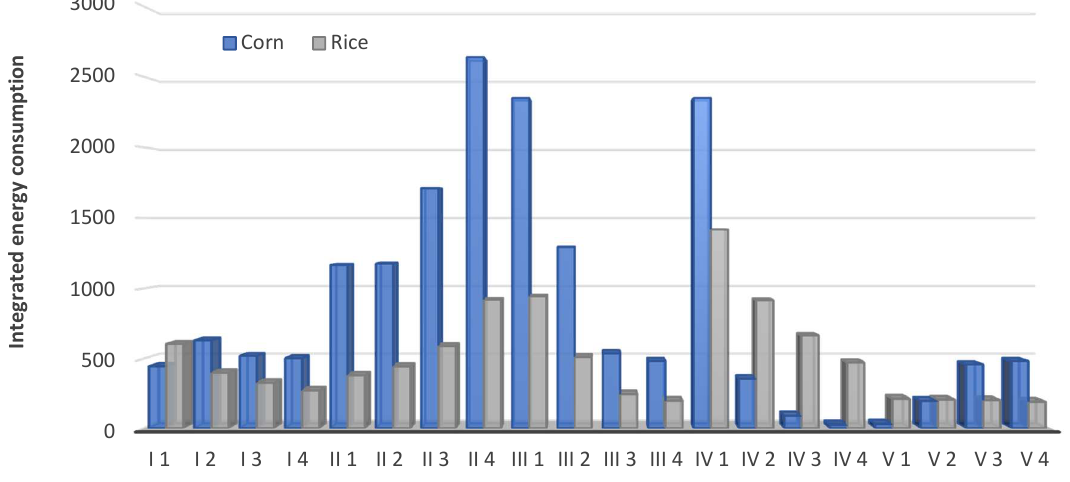
Figure 11. Test results of the integrated energy consumption for rice and corn grinding.